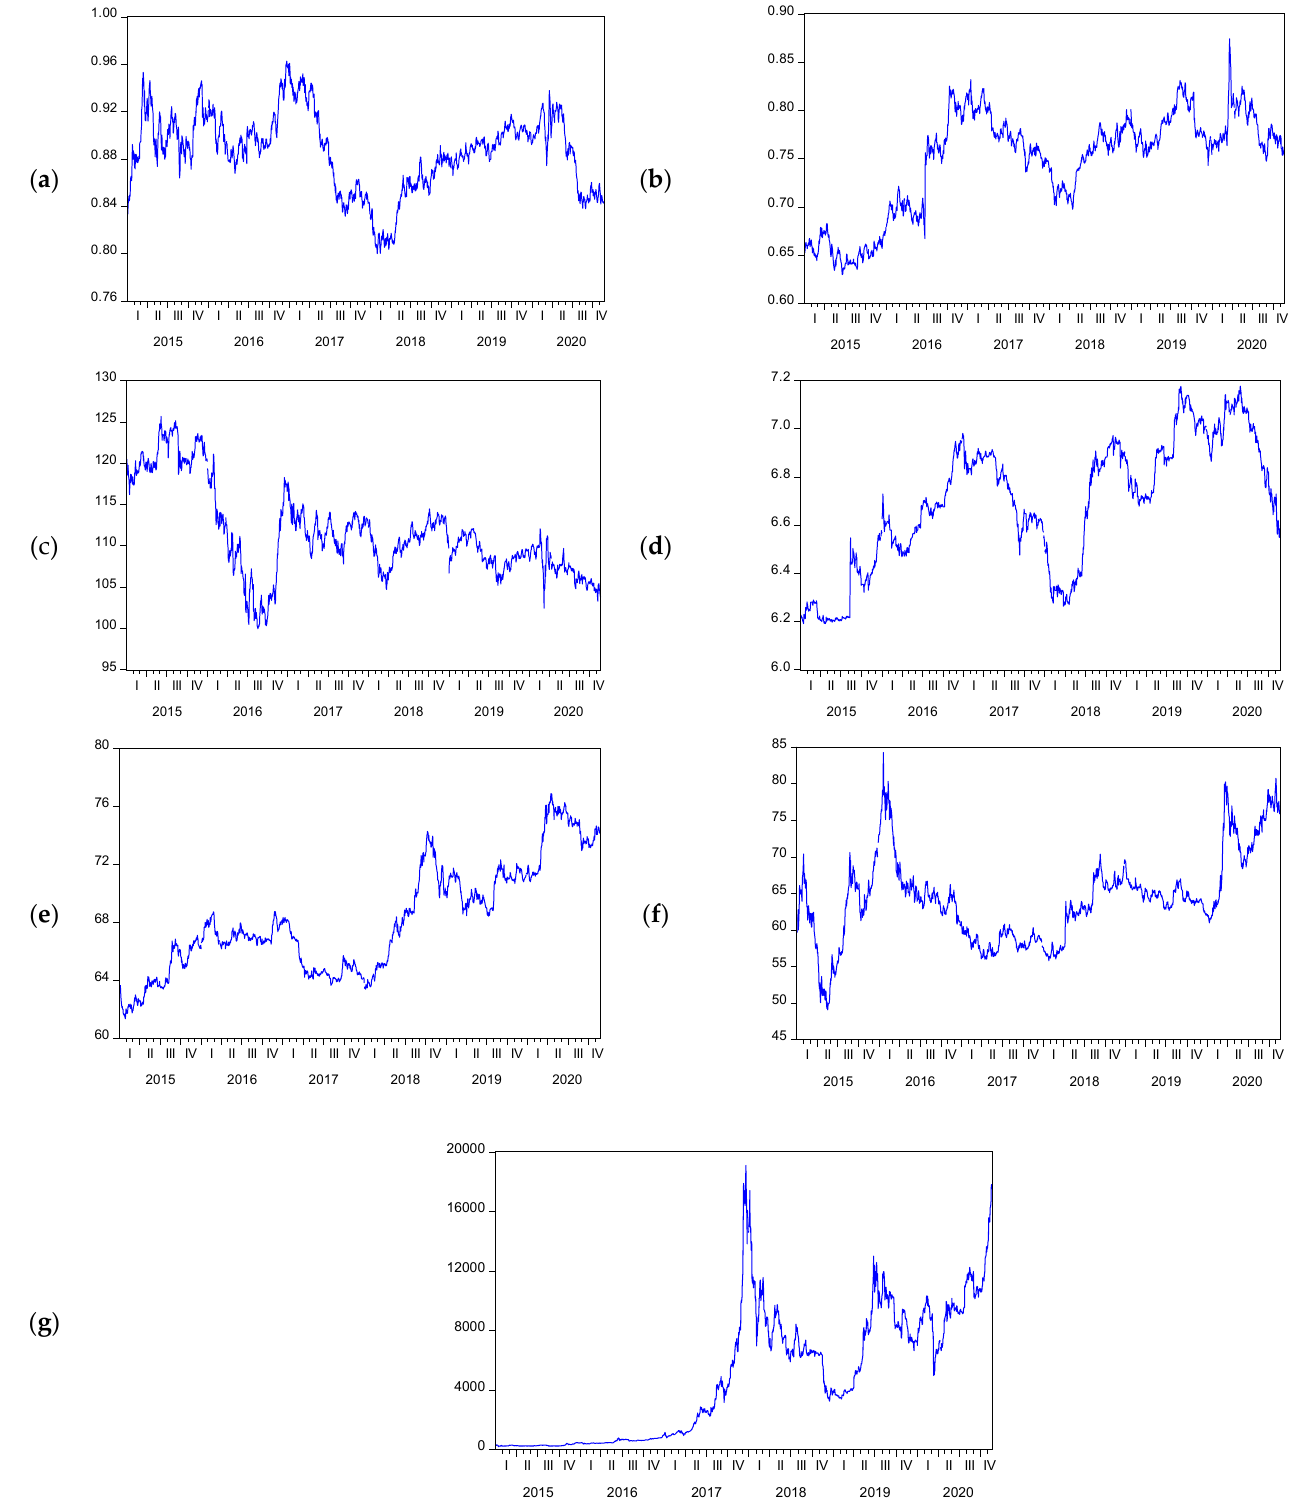
Figure 1. Price Series of Exchange Rates: ( a ) USDEUR; ( b ) USDGBP; ( c ) USDJPY; ( d ) USDCNY; ( e ) USDINR; ( f ) USDRUB; ( g ) BTCUSD.